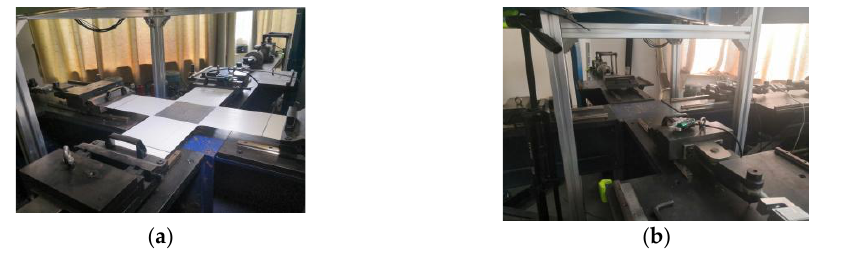
Figure 5. A specimen and the testing machine. ( a ) A specimen with a flash spot. ( b ) SJTU-I biaxial tensile testing machine